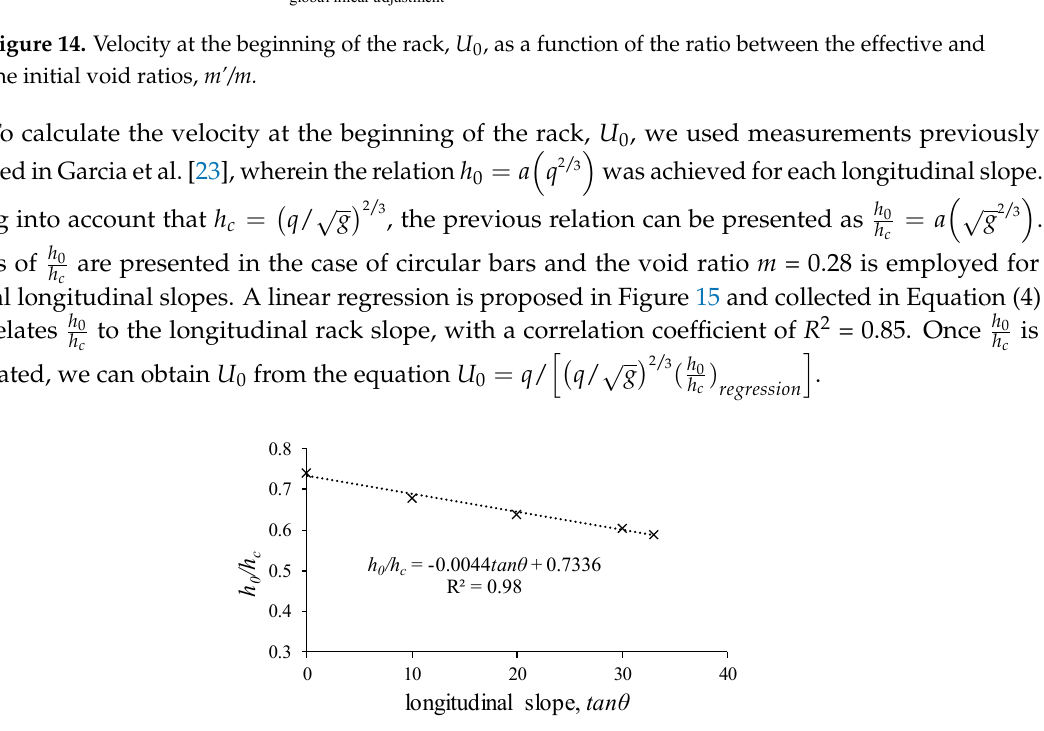
Figure 15. Ratio h 0 /h c , which is dependent on the rack slope, according to Reference [23].